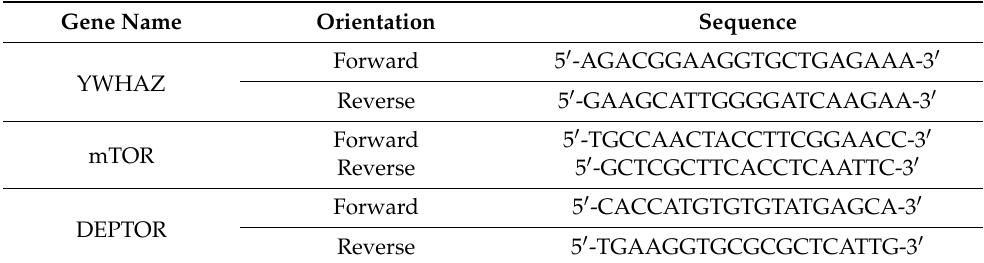
Table 2. List of primers used for RT-qPCR in this